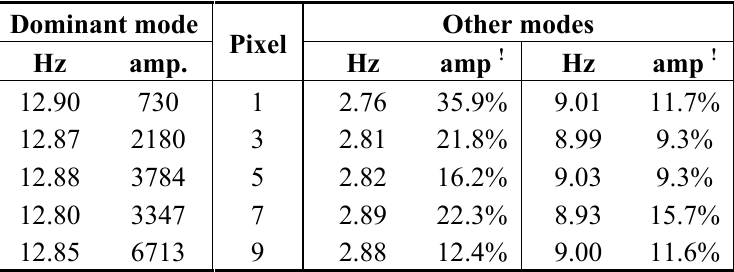
Table 9. Frequency response of the webcam with different black line thickness with enhancing light source.